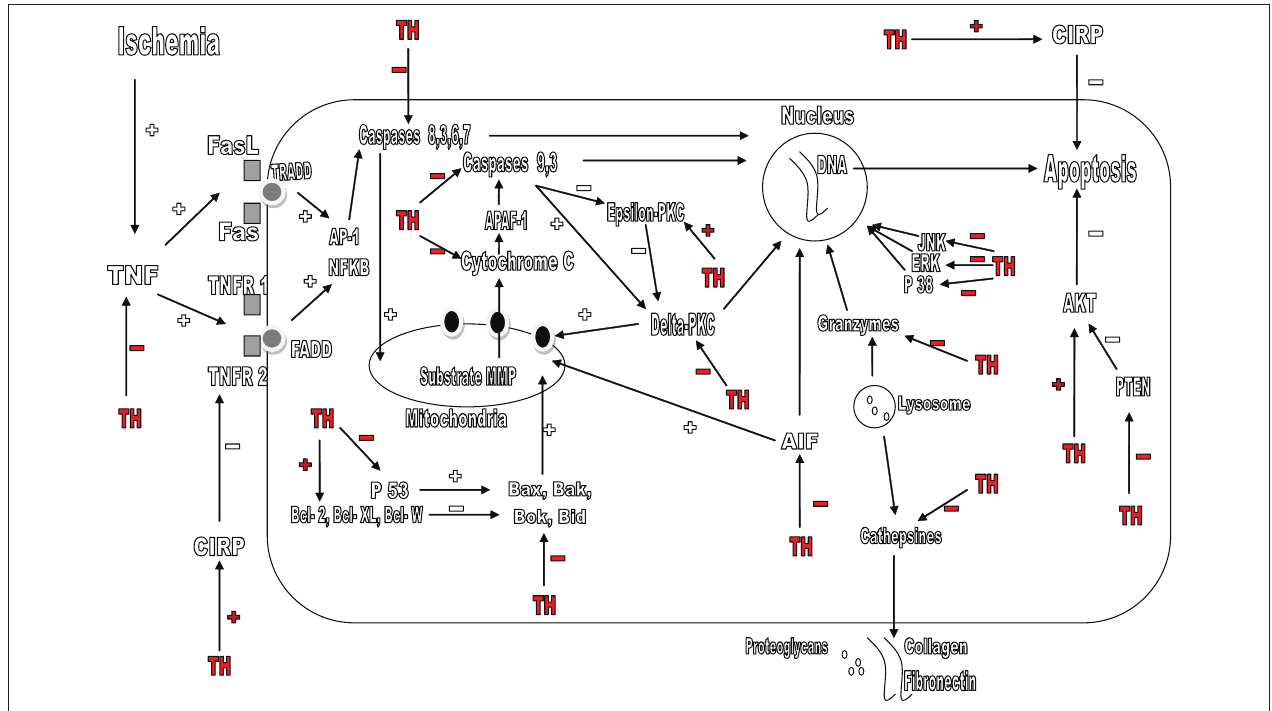
Figure 2 | Mechanisms by which therapeutic hypothermia (TH) avoids apoptosis. TH blocks the TNF pathway and, increases the levels of CIRP; it inhibits the P38, JNK, and ERK pathways. TH avoids apoptosis directly by inhibition of the caspases pathway, blocking caspases 8, 3, 6, 7, 9, and cytochrome C . TH also blocks the P53 protein and affects the Bcl-2 family, blocking pro-apoptotic proteins such as Bax, Bak, Bok, Bid, Delta-PKC, PTEN, AIF, P38, JNK, ERK, granzymes,